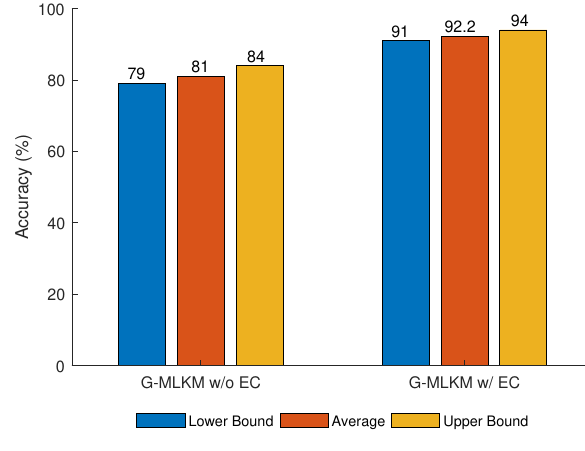
Figure 9. Accuracy obtained for graph based multi-layer k-means++ (G-MLKM) w/ EC and w/o EC. It can be observed that a higher accuracy is achieved using G-MLKM with error cor- rection than the result without error correction. Figure 9 shows the average, and maximum and minimum accuracy for both methods. The second error correction performed in the algorithm improves the average accuracy of G-MLKM by approximately 11% (G-MLKM w/ EC 92.2%; G-MLKM w/o EC